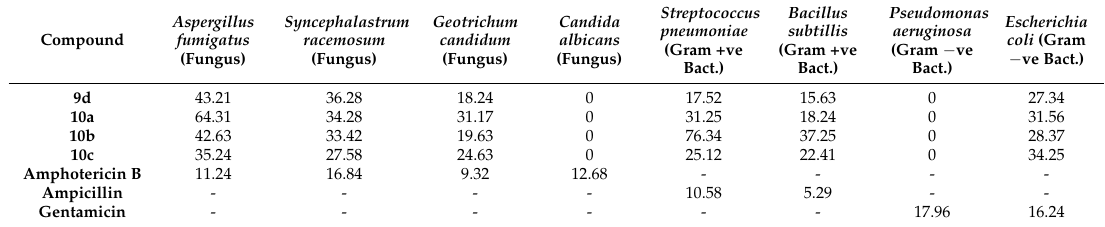
Table 3. Antimicrobial activity as half maximal inhibitory concentration (IC 50 ) (mg/mL) of tested samples against tested